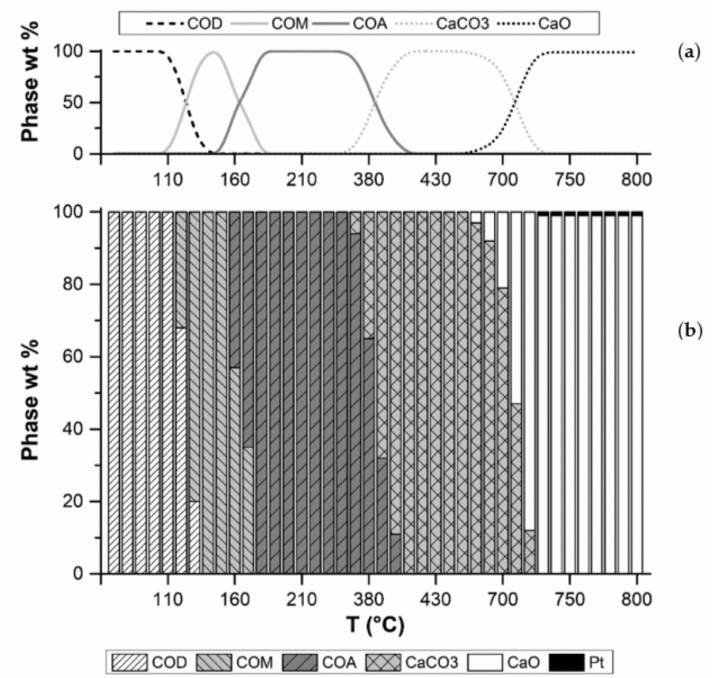
Figure 3. Ramp#3. The HT-XRPD refinement and quantitative analysis highlight the thermal stability range of the phases coming from COD thermal degradation ( a ) and the transition between crystalline phases ( b